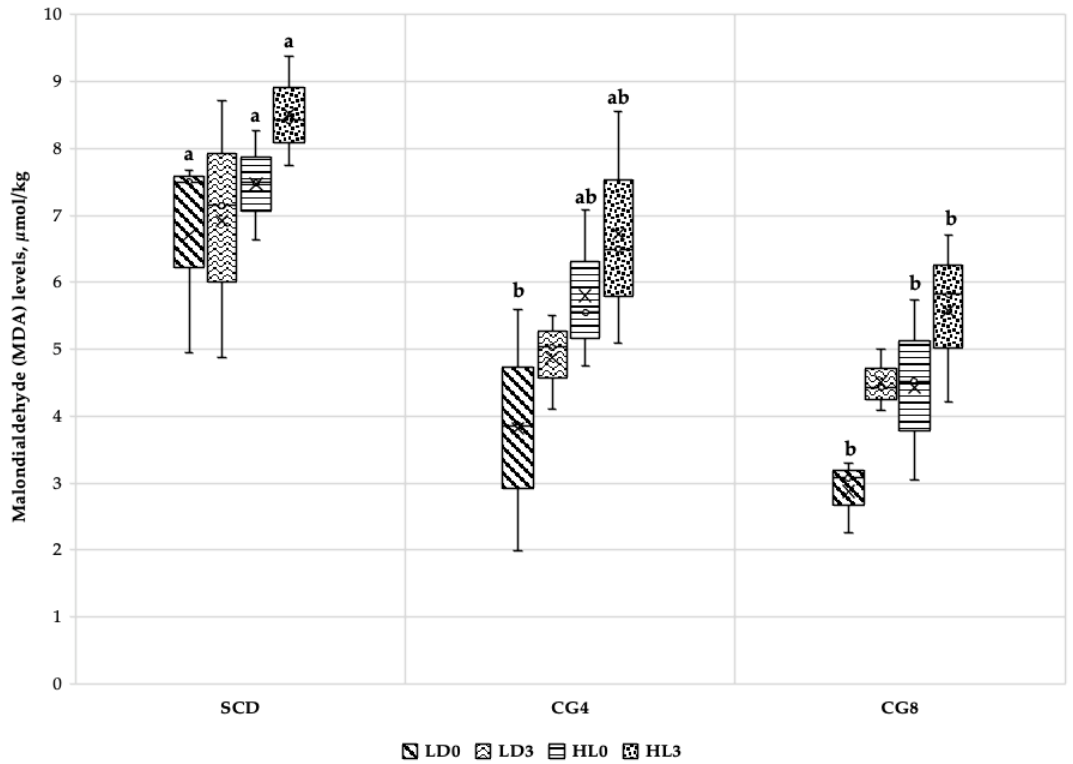
Figure 2. Impact of freshwater C. glomerata biomass inclusion in rabbit diets on malondialdehyde (MDA) levels ( µ mol/kg) in fresh (LD0 and HL0) and stored for 3 months (LD3 and HL3) rabbit muscles. SCD, standard compound diet; CG4, standard compound diet + 4% C. glomerata biomass; CG8, standard compound diet + 8% C. glomerata biomass. Columns with the same pattern but dif- ferent superscript letters (a–b) differ significantly ( p < 0.05).